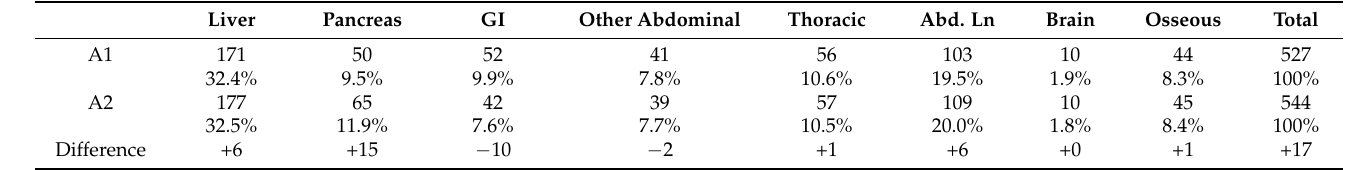
Table 1. 68 Ga-DOTATOC-PET/CT-positive lesions in NET